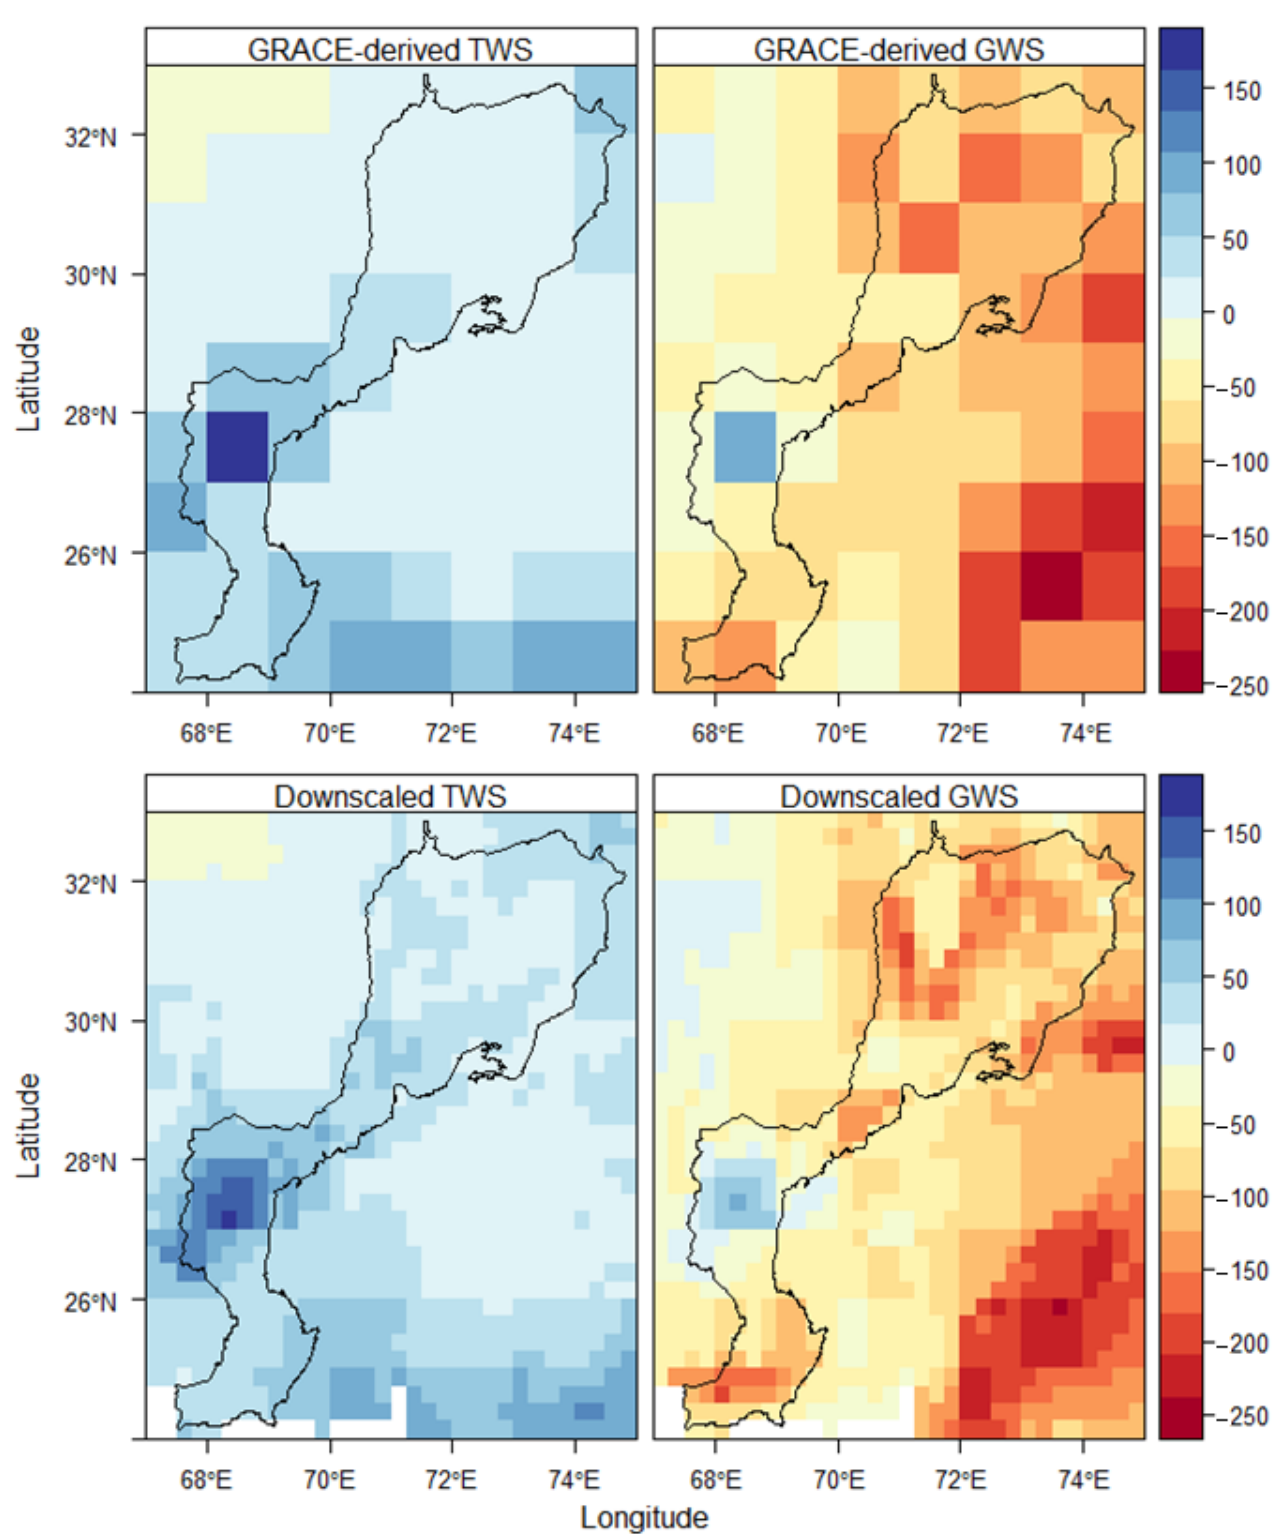
Figure 8. Original GRACE-derived TWS (mm) and GWS (mm) ( upper panel ) and RFM downscaled TWS (mm) and GWS (mm) ( lower panel ).